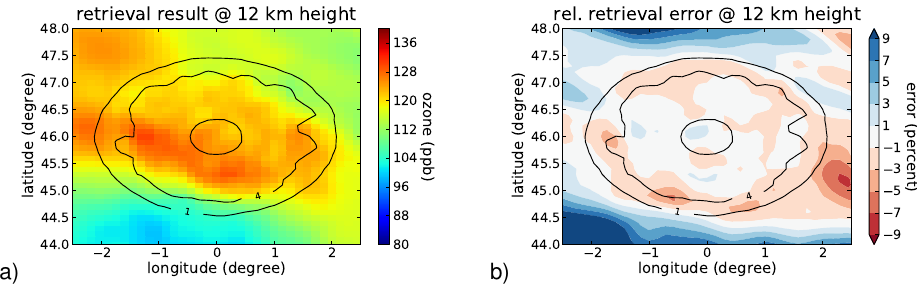
Fig. 9. The retrieval result of a tomographic retrieval using a circular flight path. Panel (a) shows the retrieved ozone values at 12 km height while panel (b) depicts the relative error in percent compared to the true values. The number of tangent points within the depicted volume elements is overlaid as a contour plot.